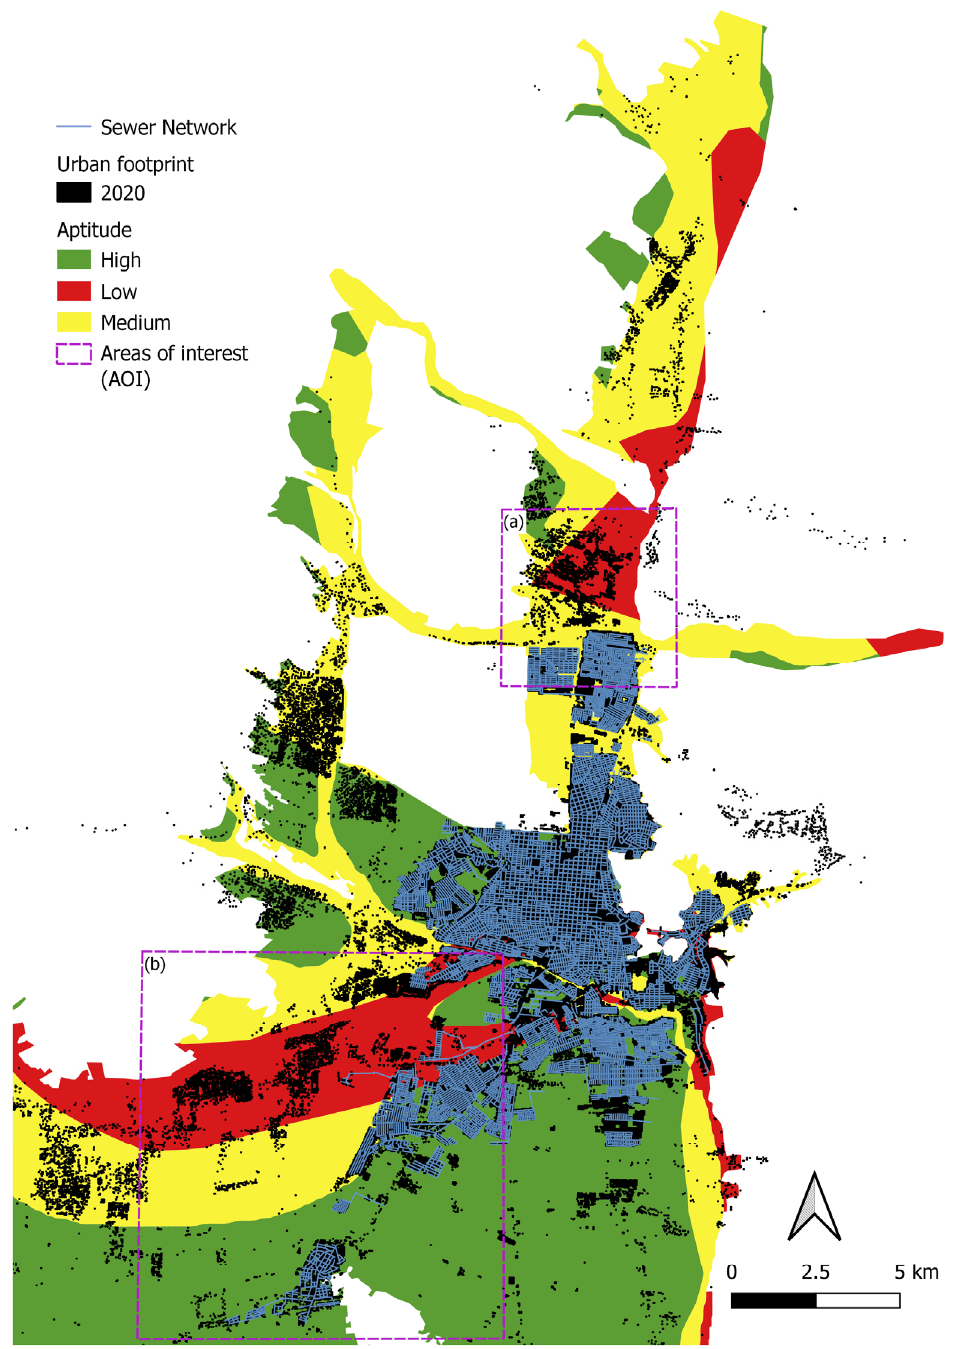
Figure 5. Aptitude map with urban areas and sewer network. AOI 1 and 2 are described in more detail in Figure 6.